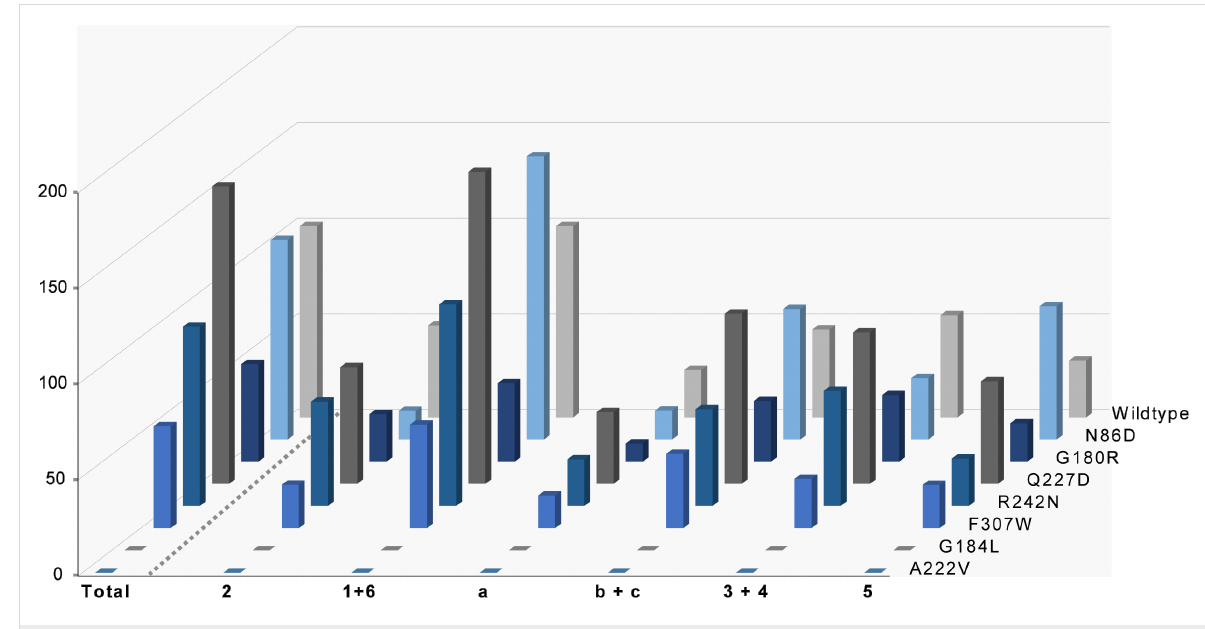
Figure 4: Products and relative activities of SmTS1 and its variants. Bars left of the dashed line show relative total sesterterpene production (wildtype = 100%), bars right of the dashed line show relative production of individual compounds (co-eluting 1 + 6 , b + c , and 3 + 4 are integrated together; 1 + 6 by wildtype = 100%; production of 7 was too low for accurate peak integration). Means from triplicates, for standard deviations cf. Sup- porting Information File 1, Table S2 and Figure